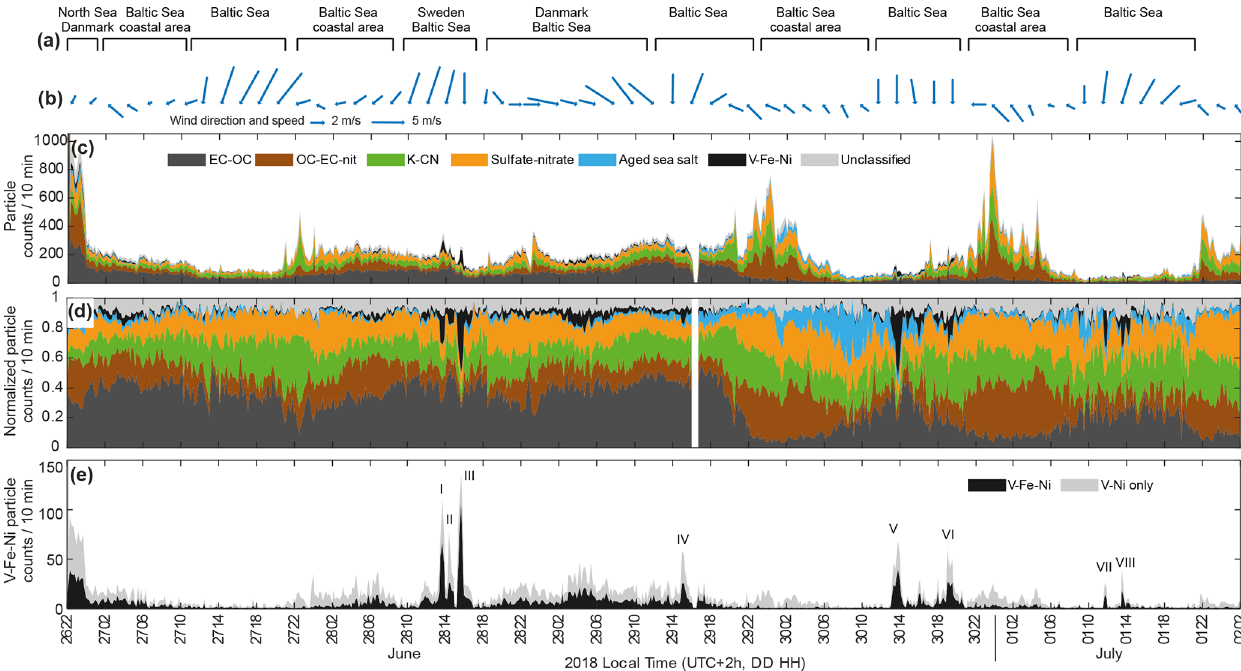
Figure 3. (a) Air mass origin (top row: > 12h, bottom row < 12h) according to the HYSPLIT back-trajectory analysis (Fig. S4). (b) Mea- sured wind data from the meteorological station at the harbor exit, 12km north of the measurement site. (c) The time series of particle counts from the general particle classes shows regional/long-range transported air pollution (26–29 June) and night-time secondary organic